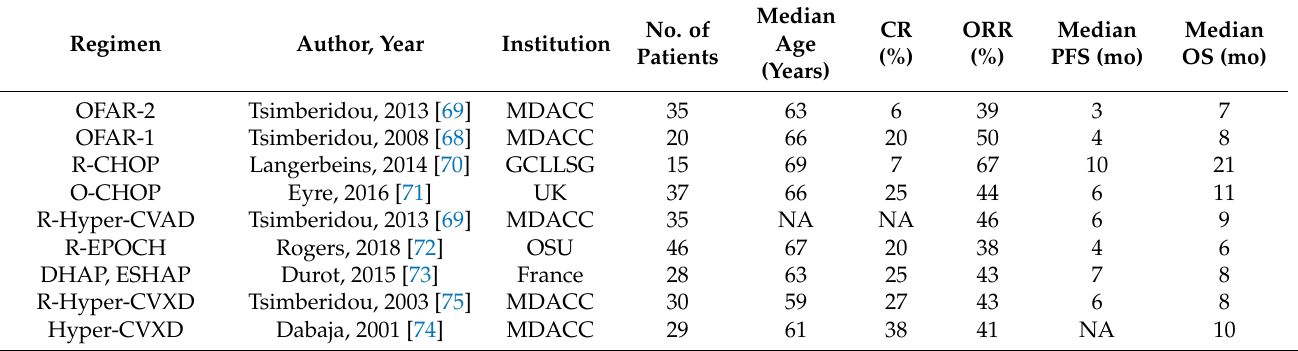
Table 2. Chemo-immunotherapy outcomes in the treatment of